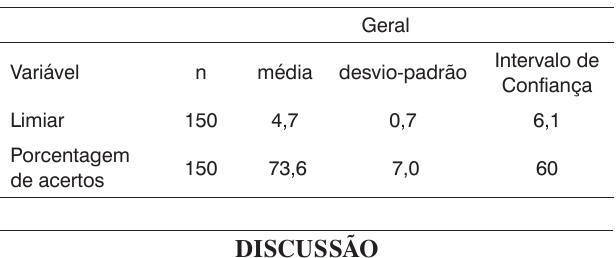
(Tableas 1 e 2). Tais resultados não evidenciam efeitos de